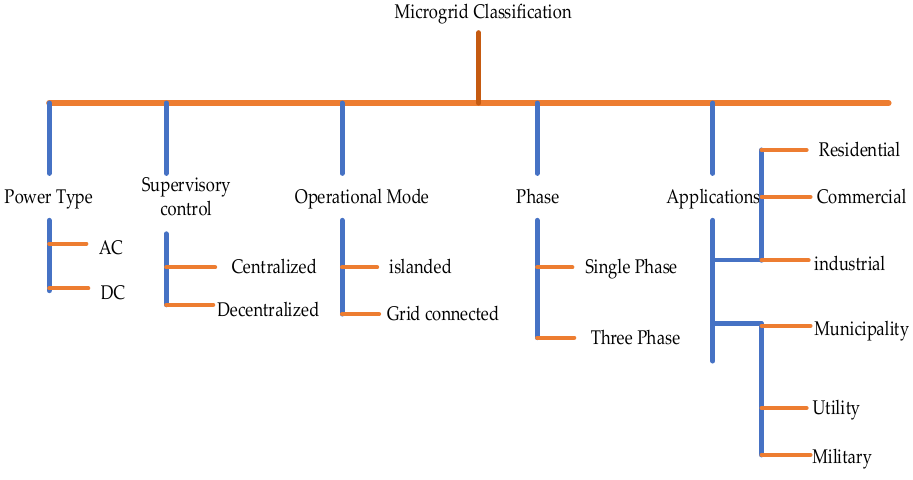
Figure 1. Classification of microgrids.